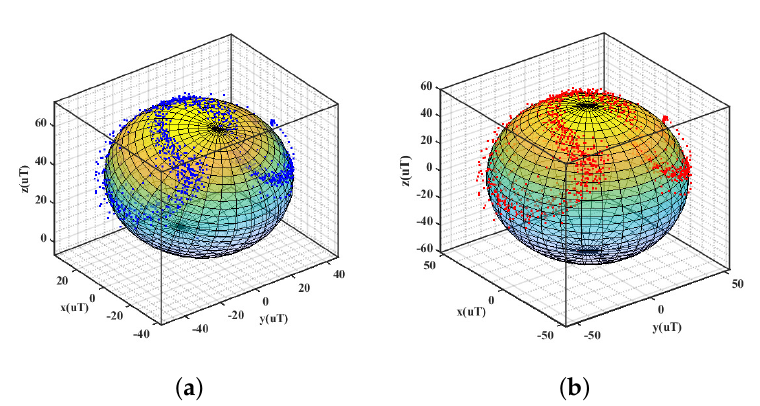
Figure 5. The calibration outcome of magnetometer. ( a ) before fitting. ( b ) after fitting.